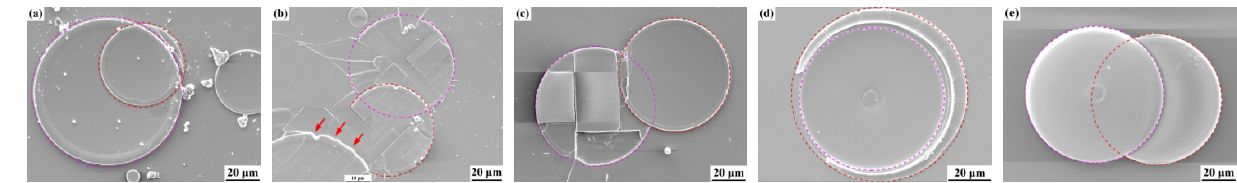
Fig. A Surface morphology of two layers of 7YSZ splats. The pink and red dashed circles represent the first and second splats, respectively. Apparently, epitaxial growth of the second splat readily occurred on the first splat.